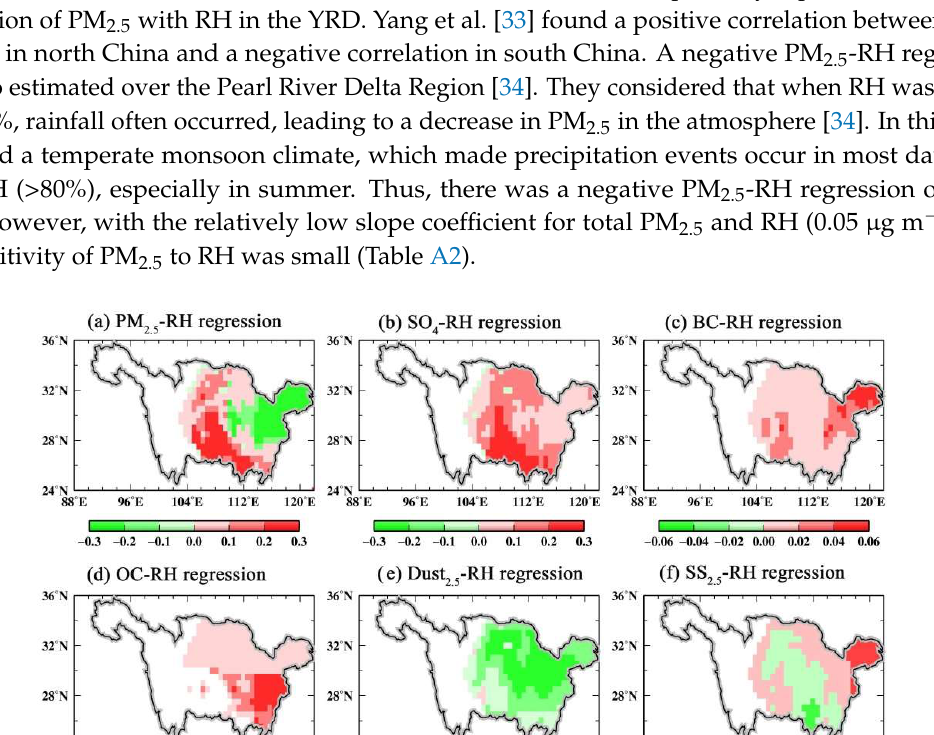
Figure 14. Multiple linear regression coefficients (β 3 ) of each PM 2.5 component with surface precipitation (Precip), in units of µg m −3 mm −1 day. Figure 14 (a), (b), (c), (d), (e) and (f) refer to the regression coefficients of PM 2.5 , SO 4 , BC, OC, Dust 2.5 and SS 2.5 with precipitation, respectively.